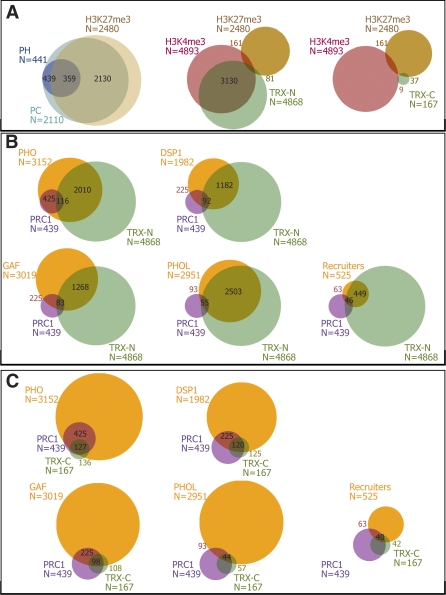
Venn Diagrams Showing Overlap between Bound Regions of Different Protein ProfilesAll the bound regions taken for analysis were with p-value < 1E−04. For PC and H3K27me3, the unstitched regions (see Text S1) were analysed. PRC1 denotes the regions cobound by PC and PH. Recruiters are the regions cobound by PHO, DSP1, GAF, and PHOL.(A) PcG binding is highly correlated. Nearly all PH sites are bound by PC and H3K27me3. Minimal overlap is seen between H3K27me3 and TRX-N/H3K4me3 or TRX-C/H3K4me3.(B) Occurrence of PcG recruitment factors along with PRC1 and TRX-N. Note that a large proportion of each factor is bound with TRX-N. Interestingly, PHO co-occurs with nearly all the PRC1 (PC+PH). PHOL minimally colocalizes with PRC1 but colocalizes extensively with TRX-N.(C) Occurrence of PcG recruitment factors along with PRC1 and TRX-C. Note the high overlap of TRX-C with PRC1.